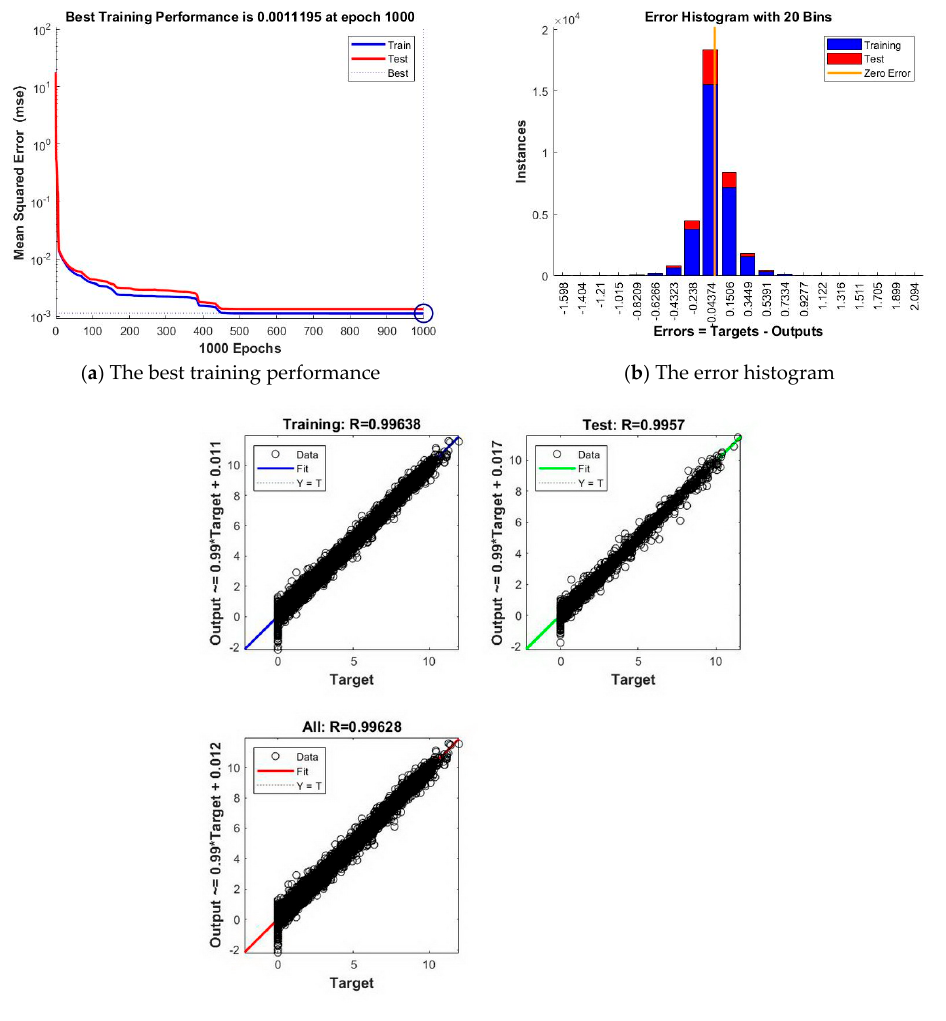
Figure 3. The performance charts corresponding to the FITNET_BR ANN.